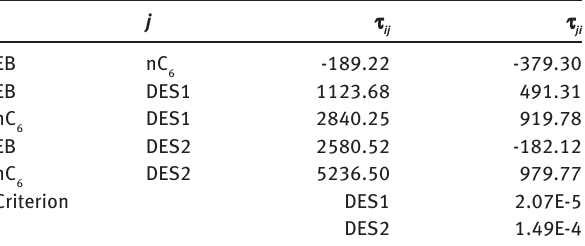
Table 5: NRTL binary interaction